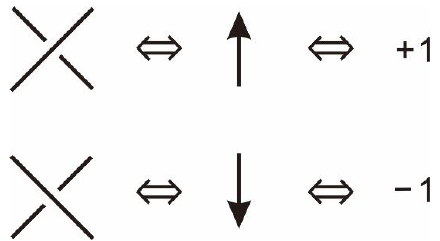
Figure 1. Mapping between a state of crossings and a state of Ising spins. Two crossing states are mapped to two spin states (up and down) with values of +1 and − 1, respectively.